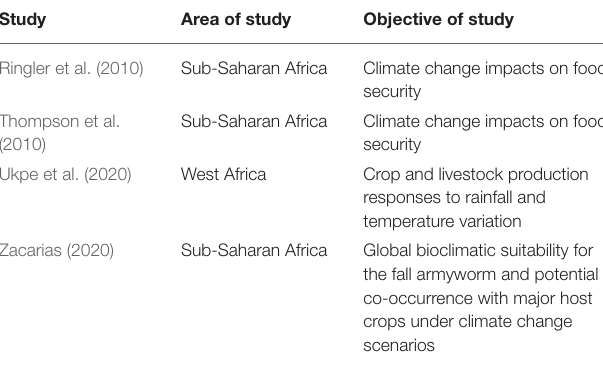
TABLE 1 | Summary of some selected